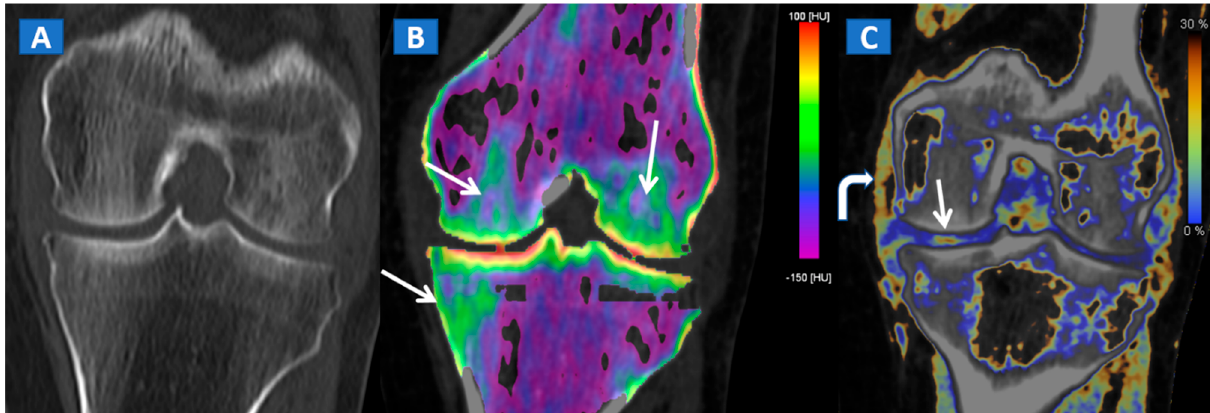
Figure 6. A 65-year-old female with a post-traumatic medial menisci rupture and diffuse BME. On the standard 1 mm reconstructed coronal CT image ( A ), there are no signs of fracture. On the corresponding 2D 1 mm reconstructed 2D DECT image ( B ), the BME appears more pronounced on the femoral condyles and on the medial tibial plateau (arrows). By using different color-coding ( C ), it was possible to identify a rupture of the medial menisci (straight arrow), with thickening and oedema of the medial collateral ligaments (curved arrow).